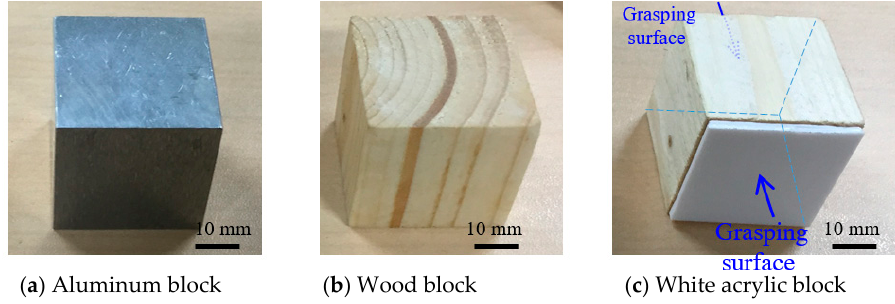
Figure 6. Pictures of target objects for grasping. ( a ) Aluminum block; ( b ) Wood block; ( c ) White acrylic block.